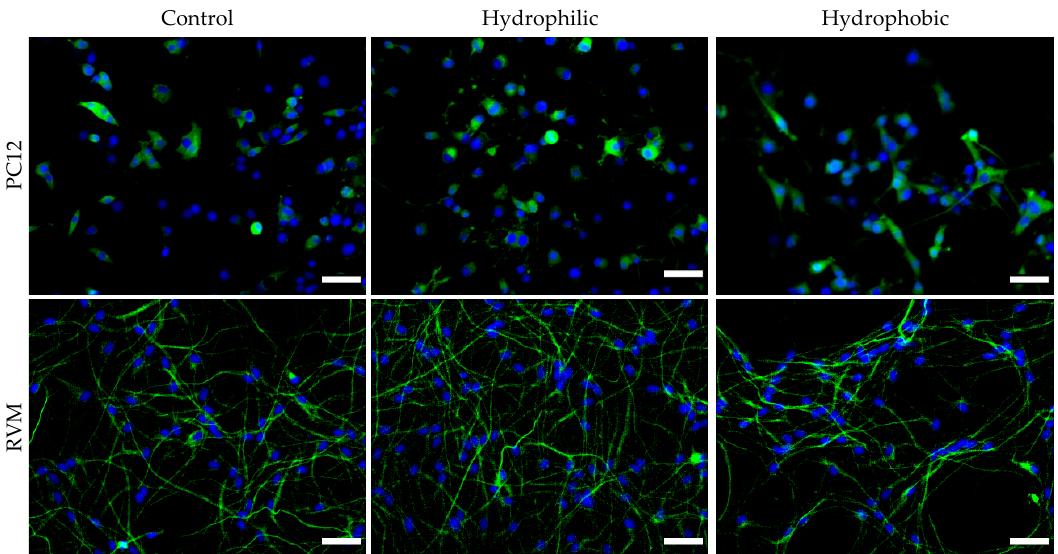
Figure 10. Immunocytochemistry of PC12 and RVM differentiated for 1 week after 24 h treatment with nanoparticles. PC12 cells were stained for GAP-43, a neuronal growth cone marker and RVM were stained for β -III tubulin, a neuronal differentiation marker. No significant differences were observed between the treatment and control groups. N ≥ 1,100 cells counted per condition and cell line. Scale bar = 50 µm.